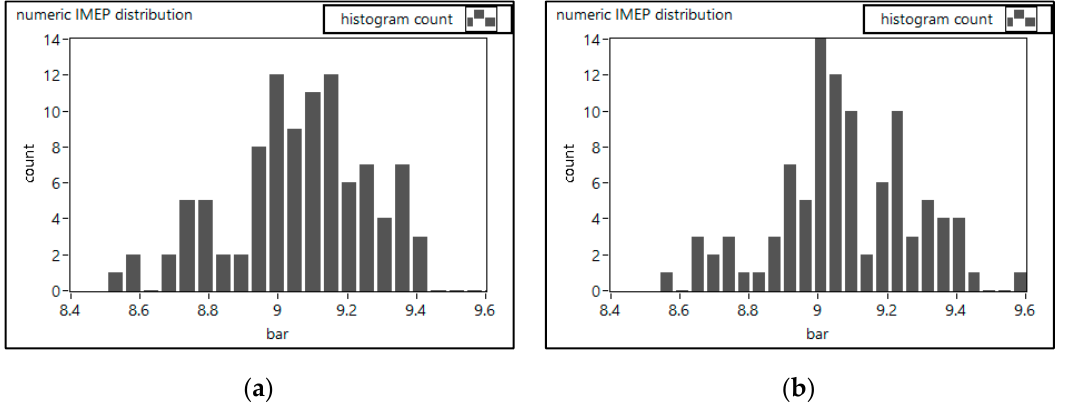
Figure 16. Histogram of numeric IMEP distribution; MAP = 1 bar, n = 3500 rpm, fuel NG. ( a ) Hill function, (mean value = 9.07 bar, SD = 0.222 bar); ( b ) Wiebe function, (mean value = 9.15 bar, SD = 0.206 bar). Table 16. Experimental and simulated IMEP SD.